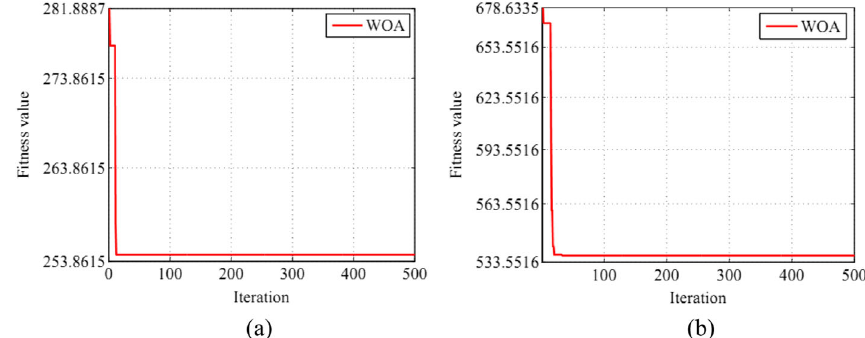
Fig. 15 Convergence characteristic of WOA in the Algerian 114-bus system, increasing of load by: (a) 20%, (b)